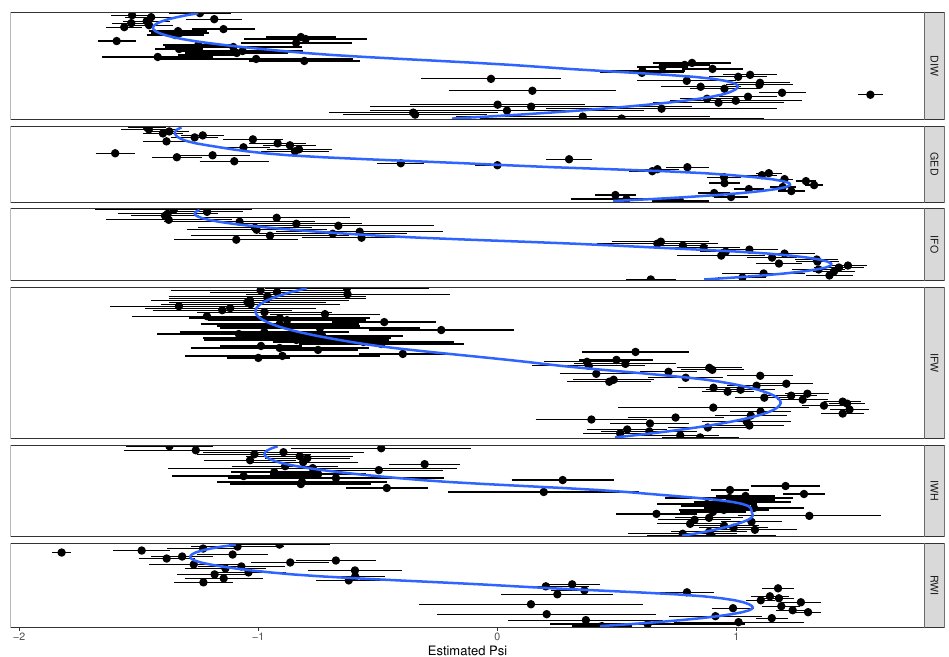
Figure 10. Estimated document positions using Wordfish (blue line is the smoothed Loess